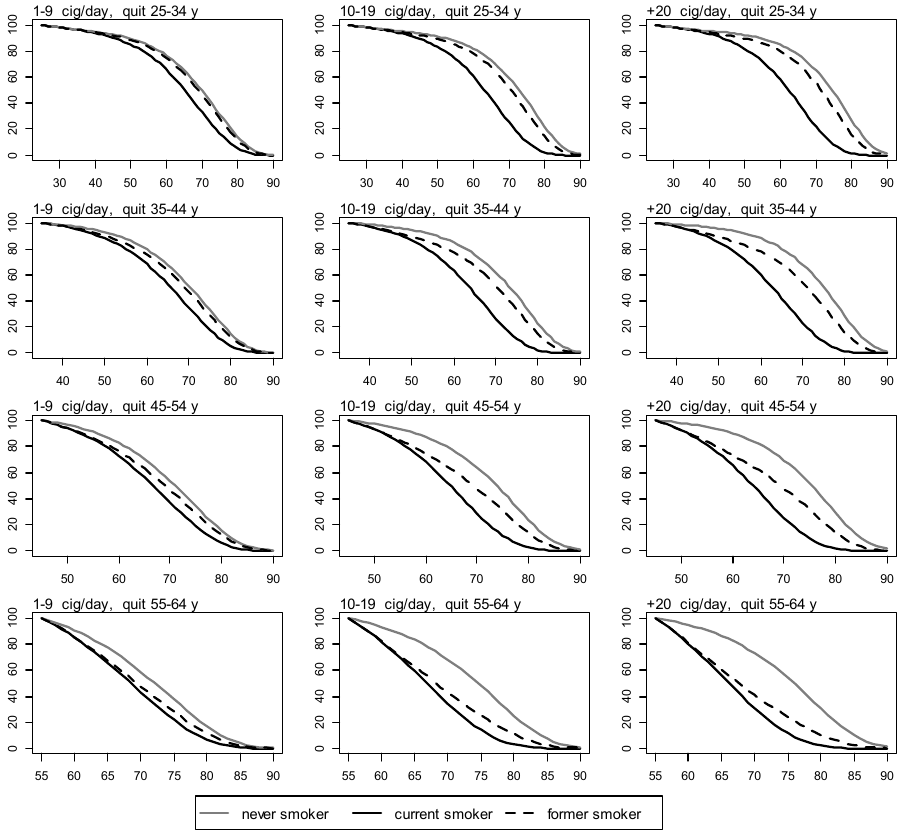
The survival curves for NS, CS, and FS, by cigarettes smoked per day and age of quitting, are shown in Figures 3 and 4 for men and women, respectively. Figure 3. Survival for never, current, and former men smokers by number of cigarettes smoked per day and age of quitting. y axis: proportion of survival. x axis: age in